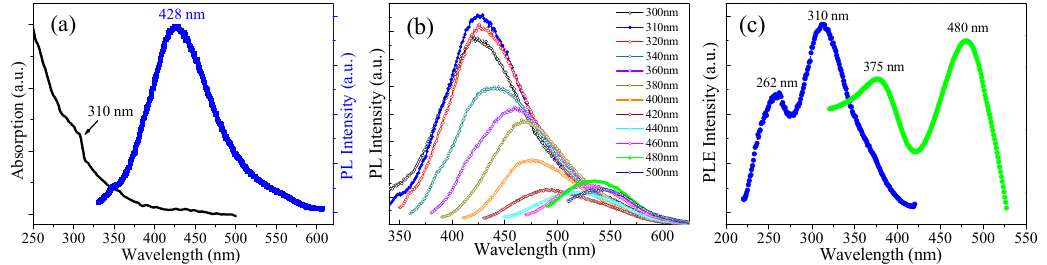
Figure 4. ( a ) The left curve is UV-vis absorption of the GQDs-F sample dispersed in water. The right curve is the emission spectrum of GQDs-F under 310 nm excitation. ( b ) The PL spectra of the GQDs-F at different excitation wavelengths. ( c ) The PLE spectrum of the GQDs-F with the detection wavelength of 428 nm (the blue curve) and 533 nm (the green curve).